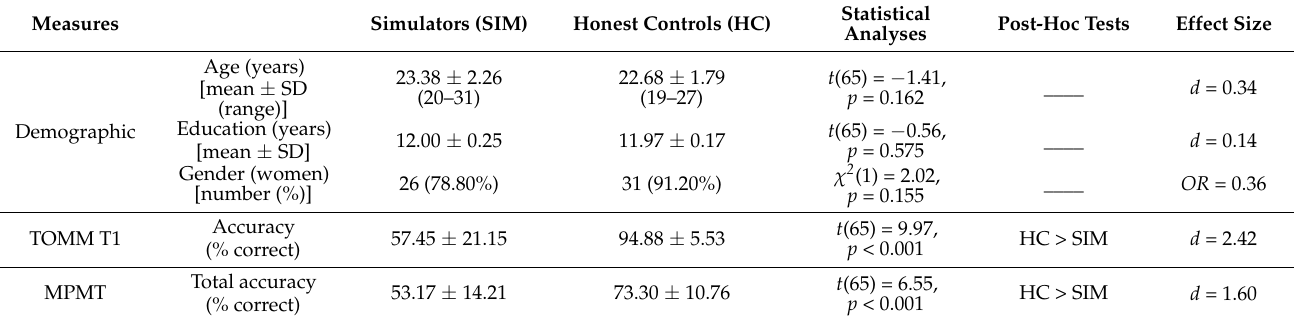
Table 1. Demographic and outcome measures of the TOMM and MPMT among simulators ( n = 33) and honest controls ( n = 34). Measures Simulators (SIM) Honest Controls (HC) Statistical